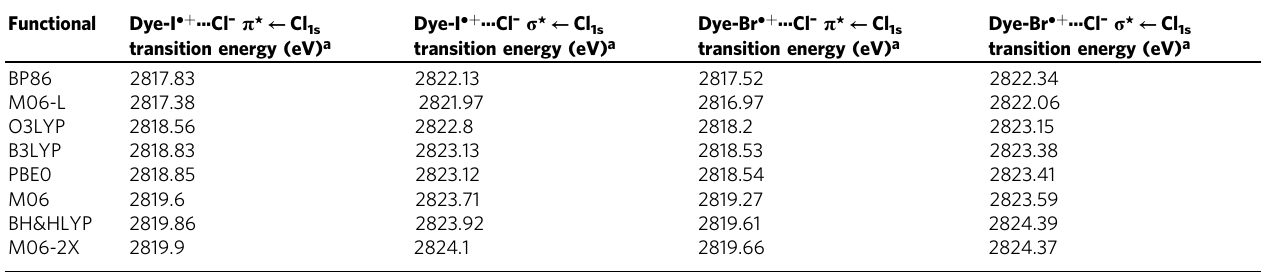
a Transition energies were shifted by a static correction factor as described in the Supplementary Methods